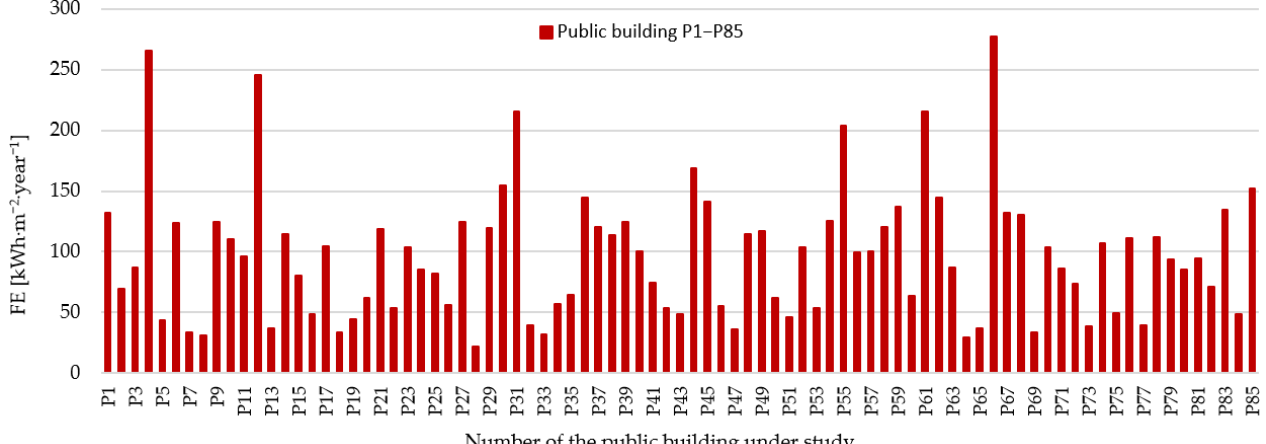
Figure 1. Comparison of the final energy demand index for heating for the studied group of public buildings.